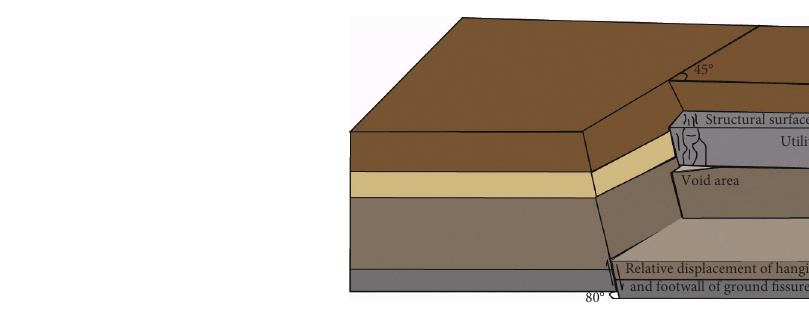
Figure 25: Diagram of void area.